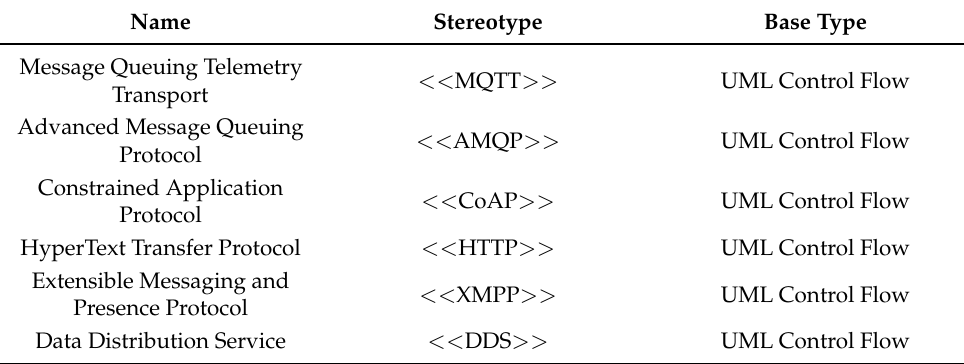
Table 5. Stereotypes for messaging